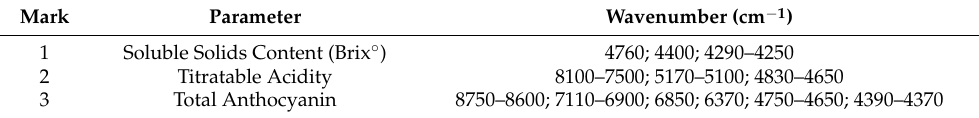
Figure 1. Raw, first and second derivative spectra of the sweet cherry and sour cherry varieties. (1: Soluble Solid Content, 2: Titratable Acidity, 3: Total Anthocyanin). Table 4. Typical vibration ranges of tested components.